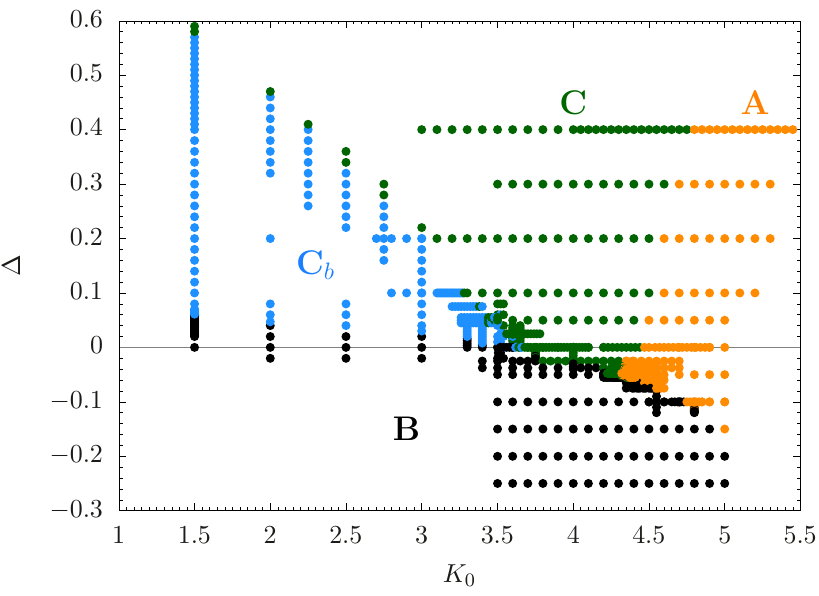
Figure 1 . The phase structure of CDT for a (cid:12)xed number of time slices T = 4 and average lattice volume (cid:22) N 41 = 160k. Blue color represents the bifurfaction phase, black color the crumpled phase, green color the C phase and orange color the A